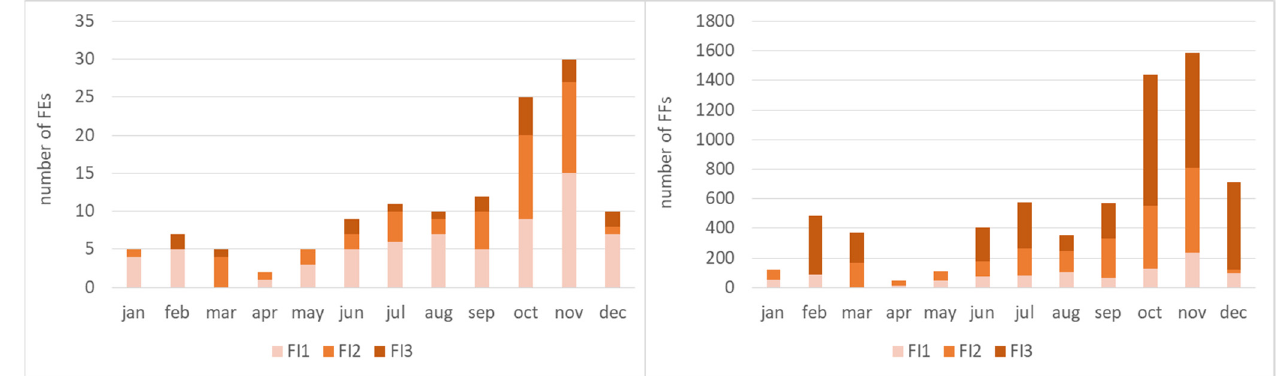
Figure 8. Monthly distribution of flood events FEs ( left ), and flood fatalities FFs ( right ), over the flood impact magnitude classes (FI).